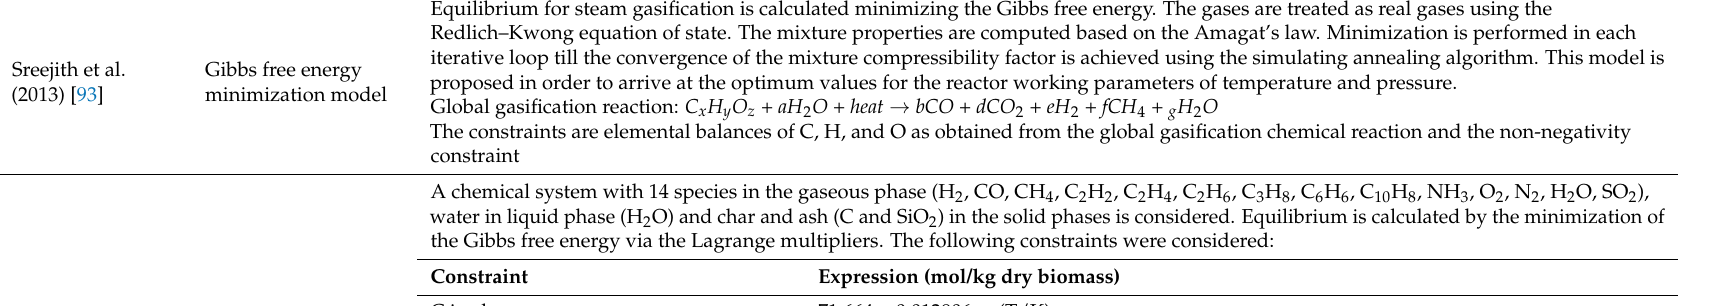
Equilibrium for steam gasification is calculated minimizing the Gibbs free energy. The gases are treated as real gases using the Redlich–Kwong equation of state. The mixture properties are computed based on the Amagat’s law. Minimization is performed in each iterative loop till the convergence of the mixture compressibility factor is achieved using the simulating annealing algorithm. This model is proposed in order to arrive at the optimum values for the reactor working parameters of temperature and